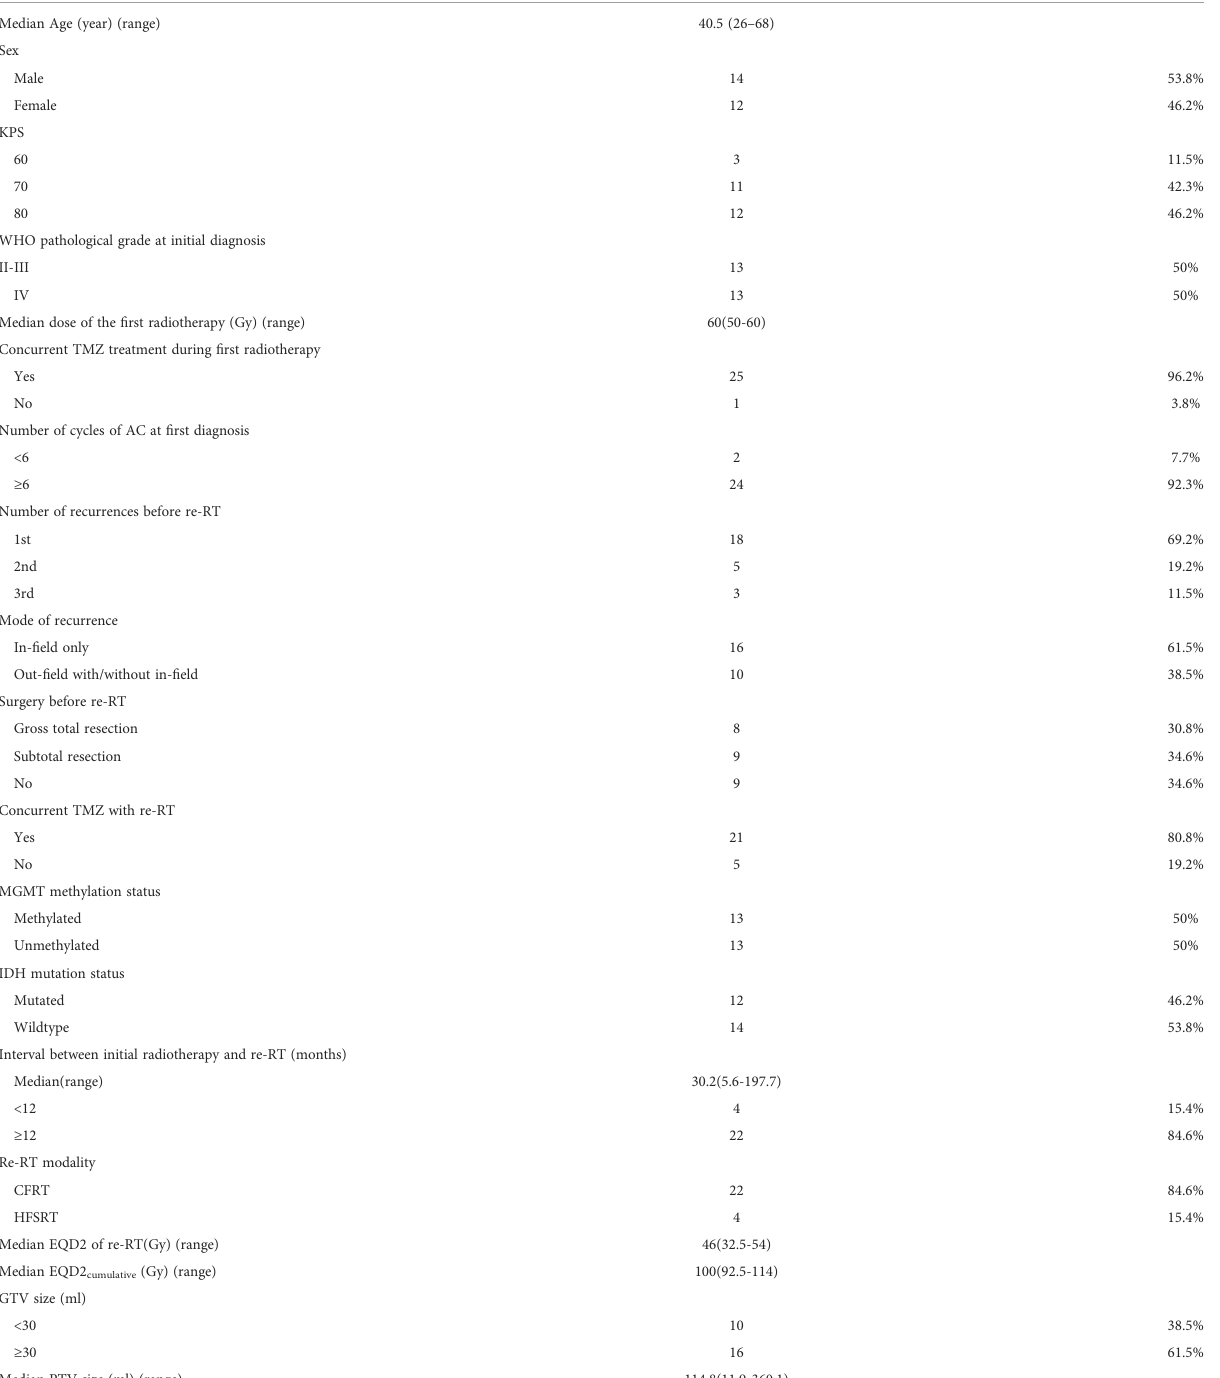
TABLE 1 Patient characteristics ( N =